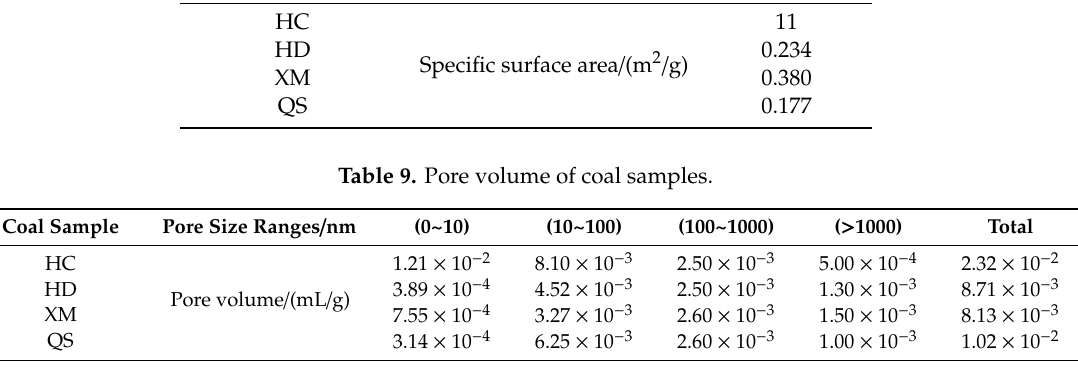
Figure 12. The impact of pore volume on  D ae ,  D ie and  k Φ.